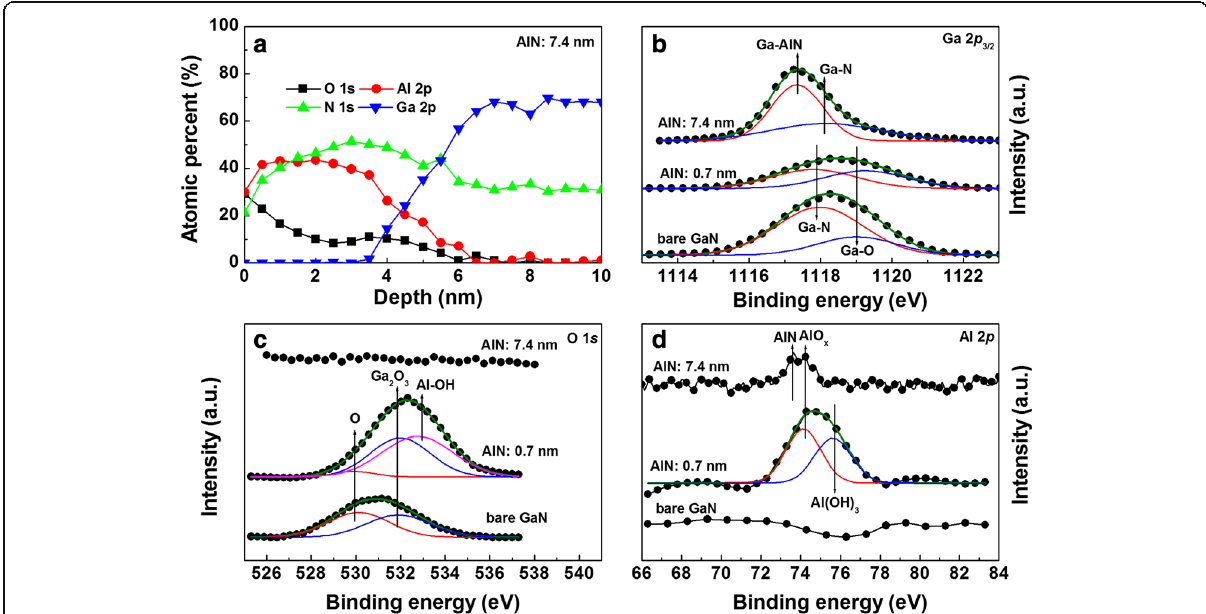
Fig. 6 a XPS depth profiles for each element obtained from the sample with a 7.4-nm-thick AlN. XPS core-level spectra of b Ga 3 p 3/2, c O 1 s , and d Al 2 p for the samples with 0-, 1.5- and 7.4-nm-thick